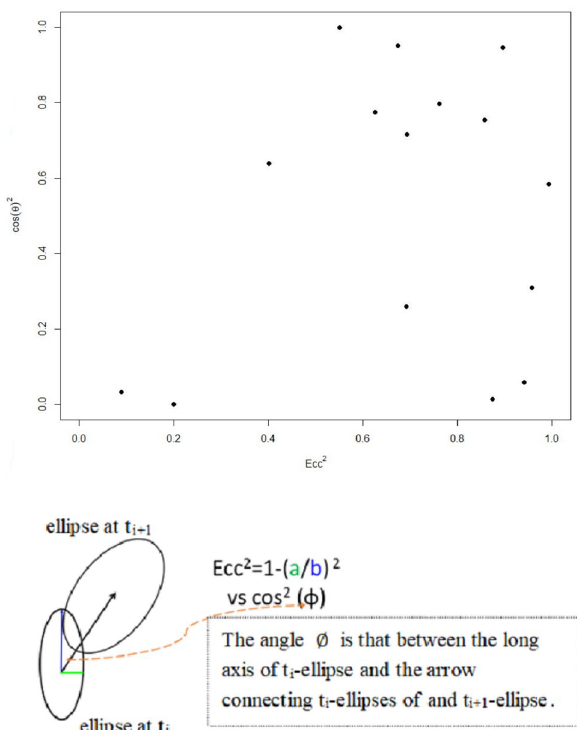
Figure 5. (Upper panel) The relationship between the eccentricity of the SDE in the two counties (YL and PT) and the angle ( cos ( ∅ )) between two SDEs depicted for 2 weeks (t i and t i+1 ). Squaring makes the data points look better dispersed. Two dotted lines are taken for eccentricity = 0.8 (Ecc 2 = 0.64) and cos ( ∅ ) =0.8 ( cos (Lower panel) Illustrating the calculation of cos ( ∅ )